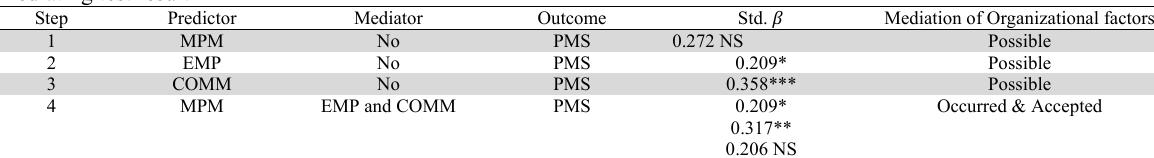
Table 3 indicated that model fit indices of model and CFA had served all the criteria accordingly to the given threshold. Mediating test